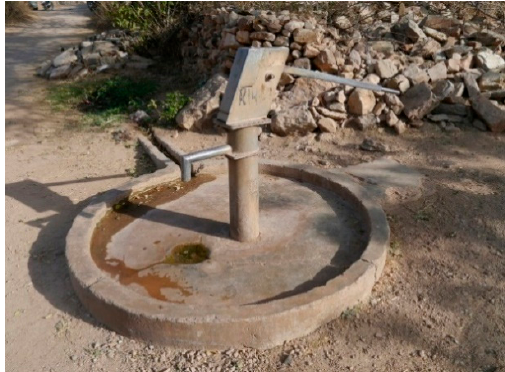
Figure 14. Water pump in Badi, 2017 (picture by author).